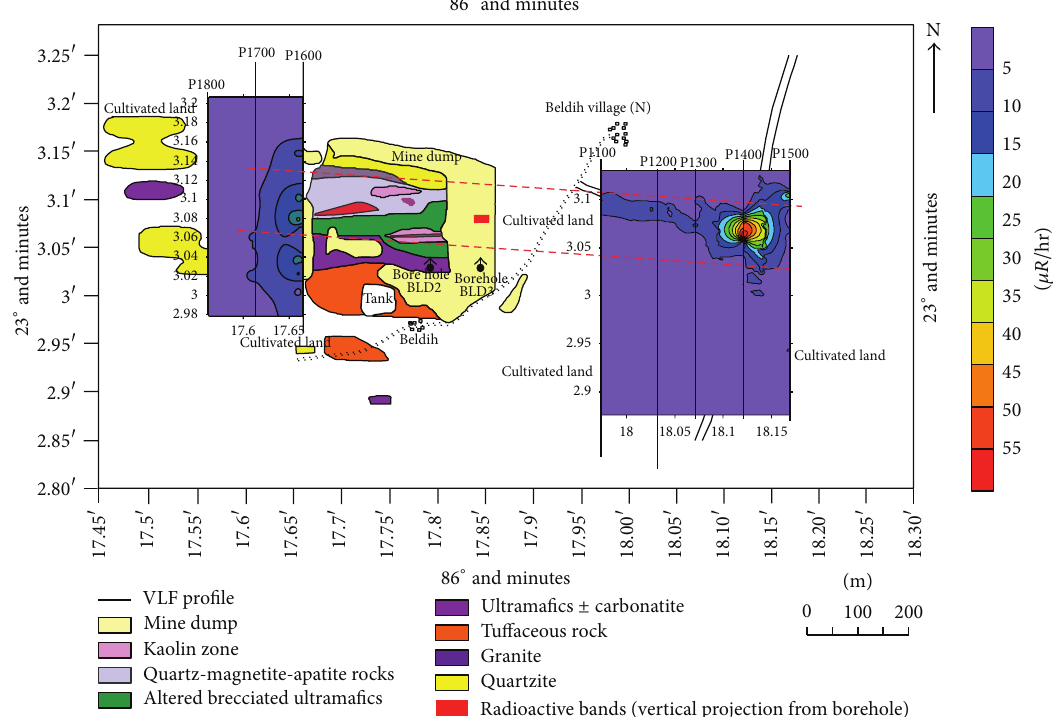
Figure 10: Surface gamma activity superimposed over geological map of the area of study.